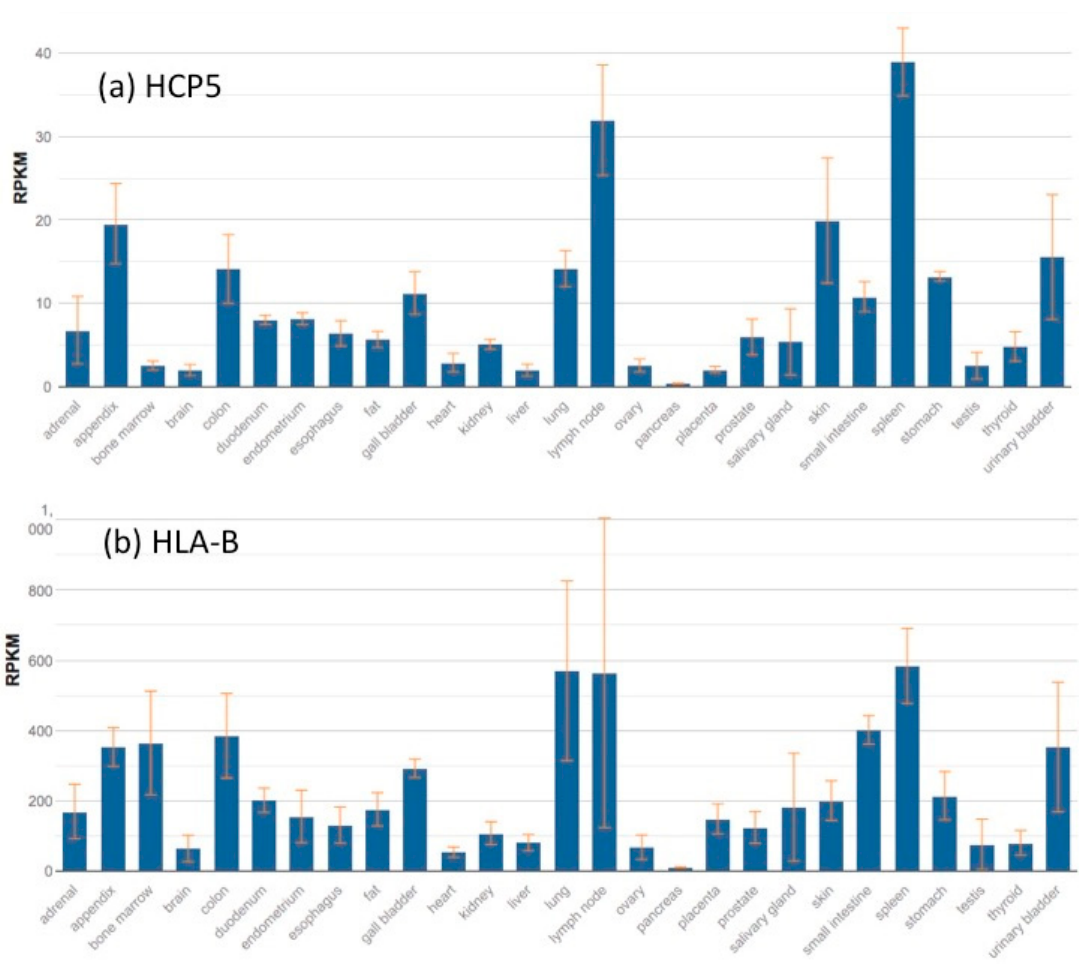
Figure 3. HCP5 ( a ) and HLA-B ( b ) RNA sequences in 27 different normal tissues from 95 human individuals. NCBI BioProject PREJEB4337. RPKM (reads per kilobase of transcript per million mapped reads) on the y- axis is a normalized unit of transcript expression [60].